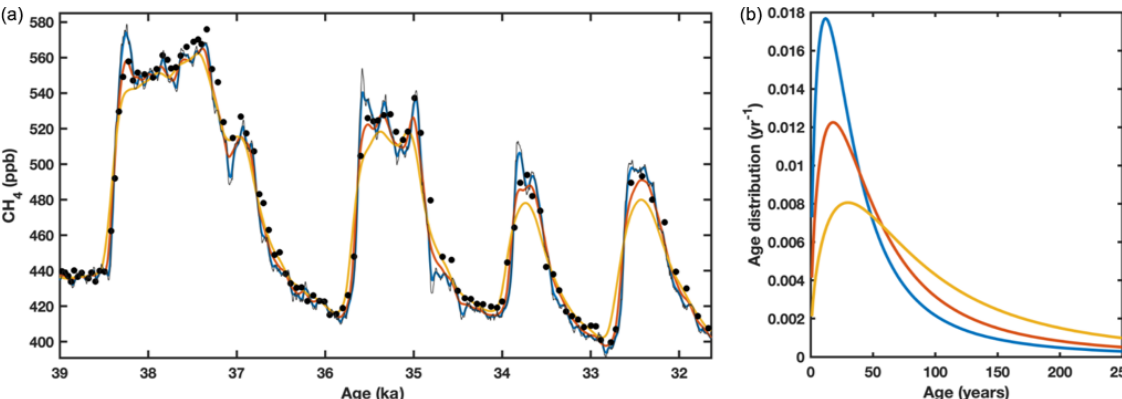
Figure 6. (a) SPC14 data (black dots) compared with smoothed WD CH 4 record. Colored lines show the result of smoothing the WD record with progressively wider age distributions. Original signal (gray) is plotted against three example smoothed histories: α = 0 . 01 (blue), α = 0 . 03 (red), α = 0 . 05 (yellow) of (cid:49) age. The best fit between the smoothed WD record and SPC14 data occurs for α = 0 . 03 (or 3.0% of (cid:49) age). (b) Width of the smoothing filter is defined by the spectral width, which is proportional to a percentage of (cid:49) age; in panel (b) , 2000-year (cid:49) age is demonstrated. Colors of the age distributions correspond with the smoothed signals in (a)